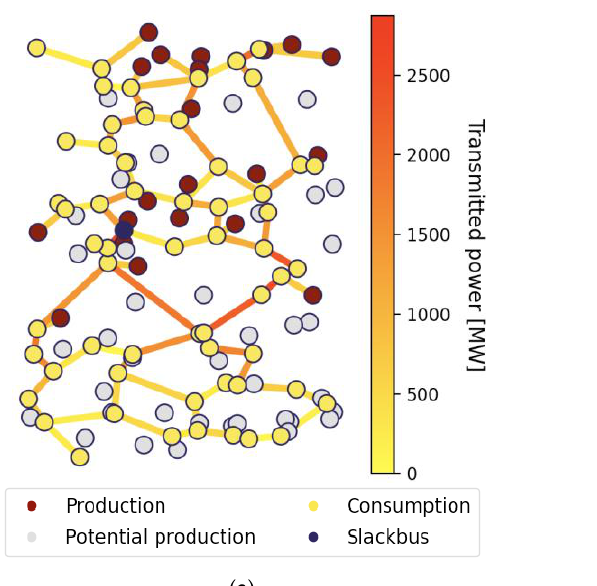
Figure 3. Solar production scenario with a square map area: ( a ) With base case; ( b ) Reference case when the network distance-based value loss was 20%/1000 km.